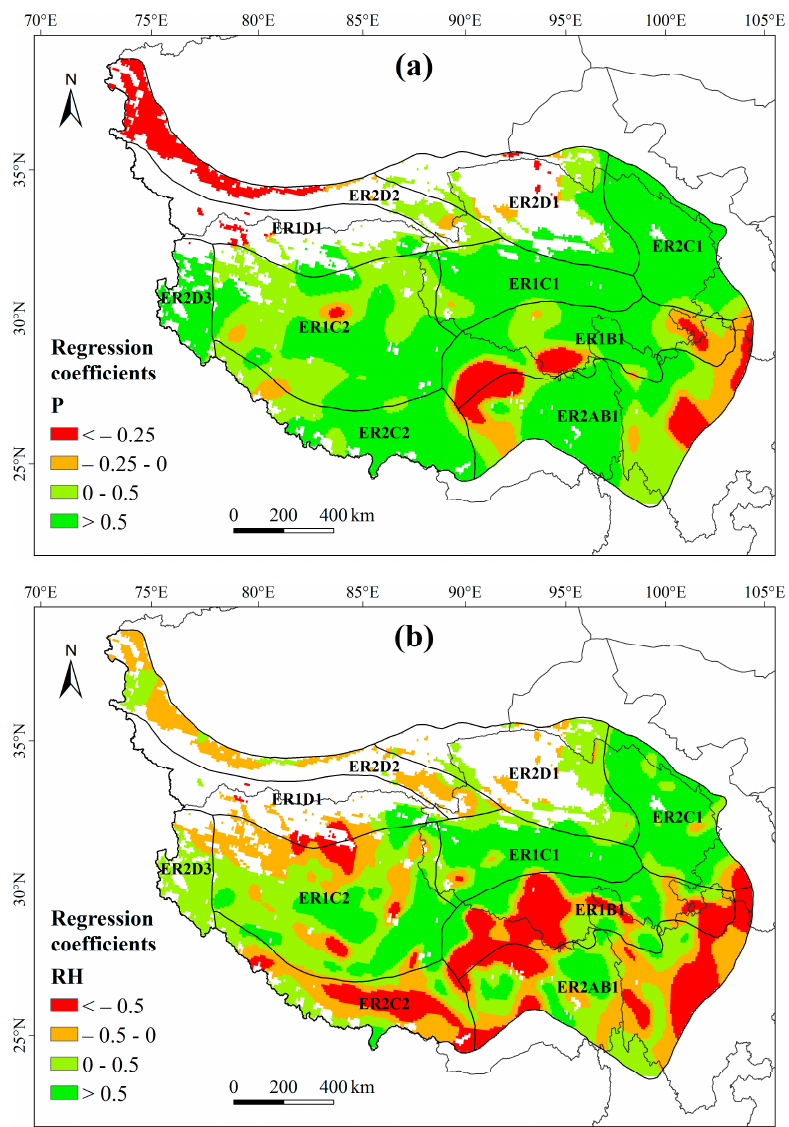
Figure 4. The spatial pattern regression coefficients for moisture (( a ): P ; ( b ): RH ) in the geographically weighted regression